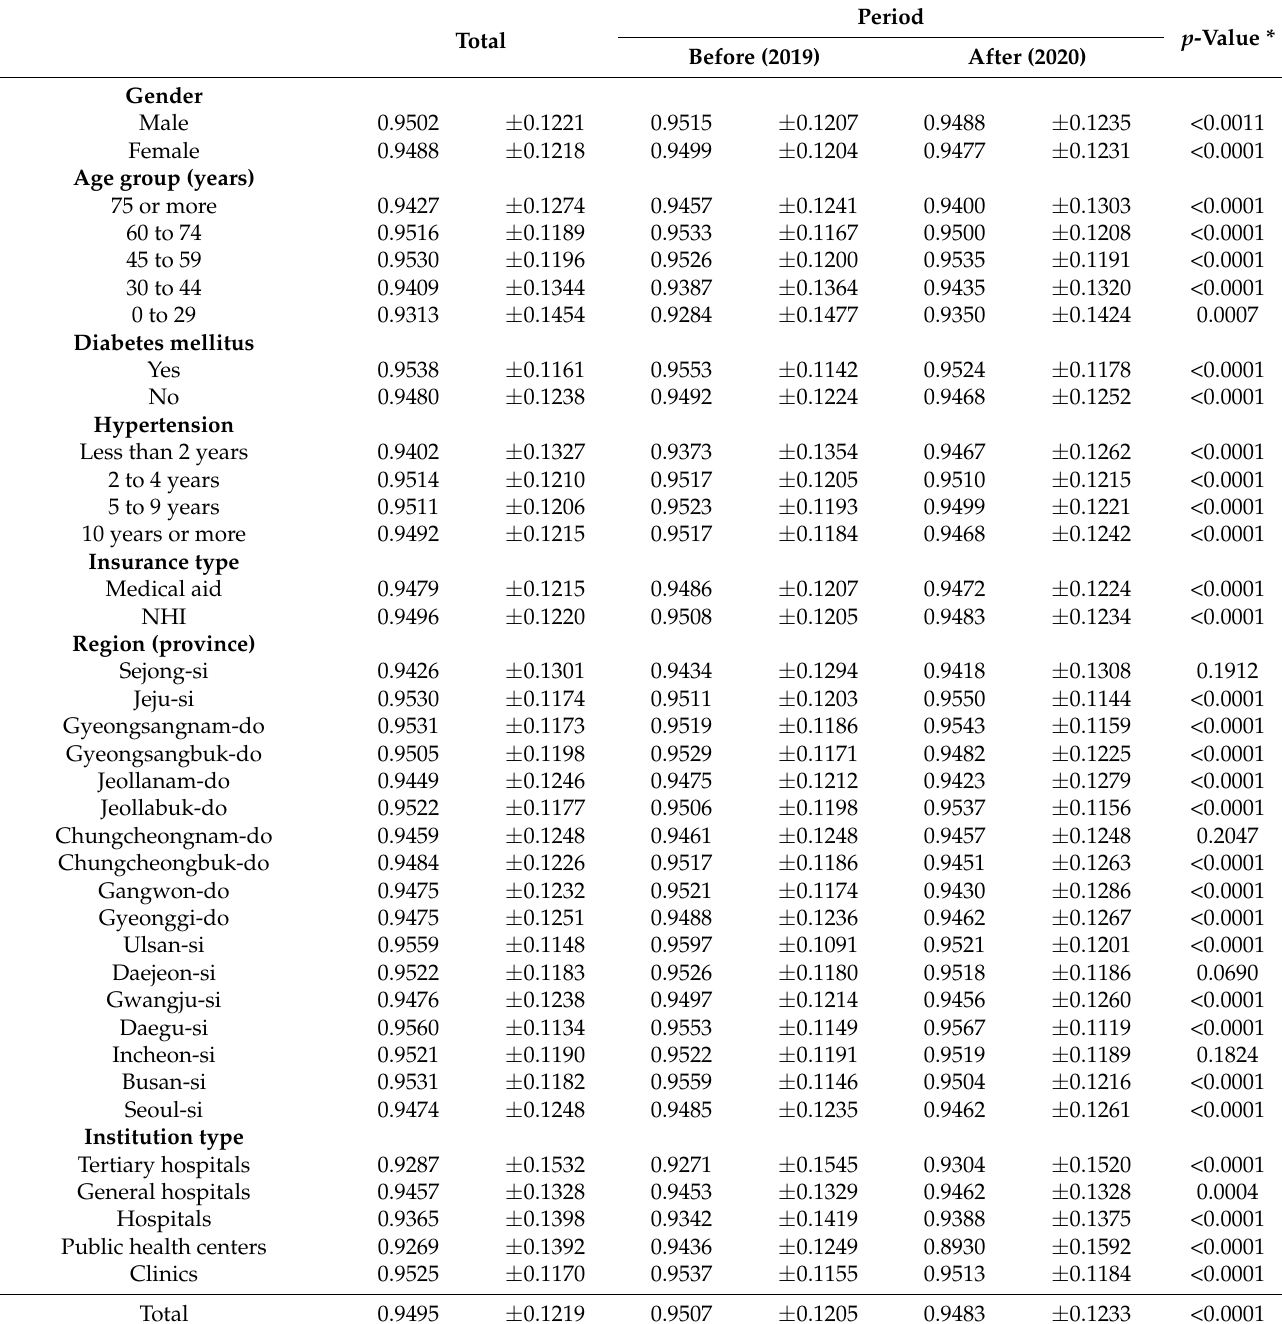
Table 2. MFPC of the general population (mean ± standard